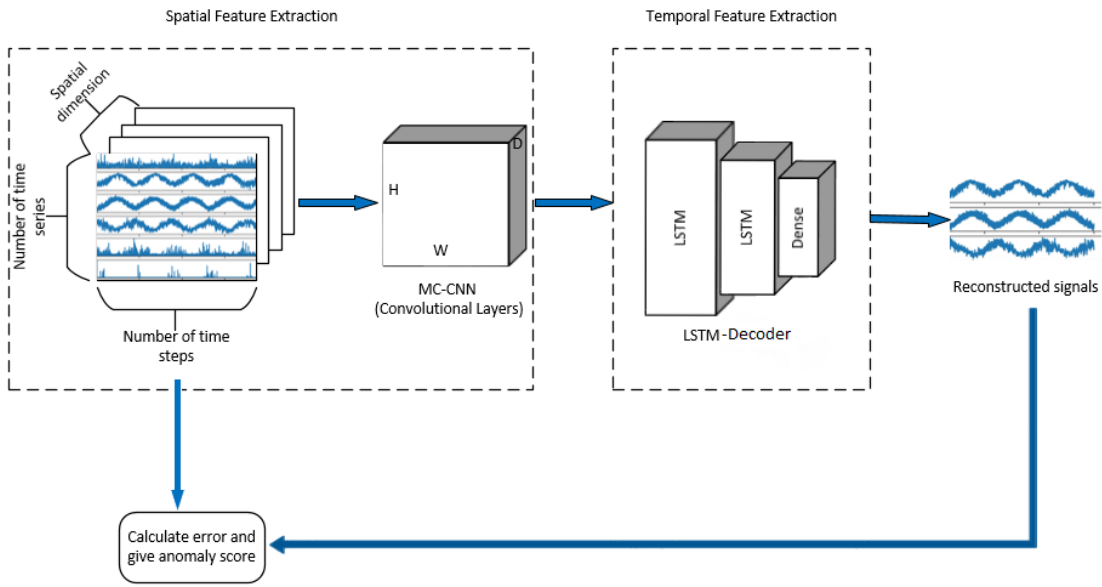
Figure 3. Overall architecture of the proposed hybrid deep learning framework. It has two main components: A multi-channel convolutional encoder (MC-CNN-Encoder) for spatial encoding and an LSTM-based decoder for temporal decoding.